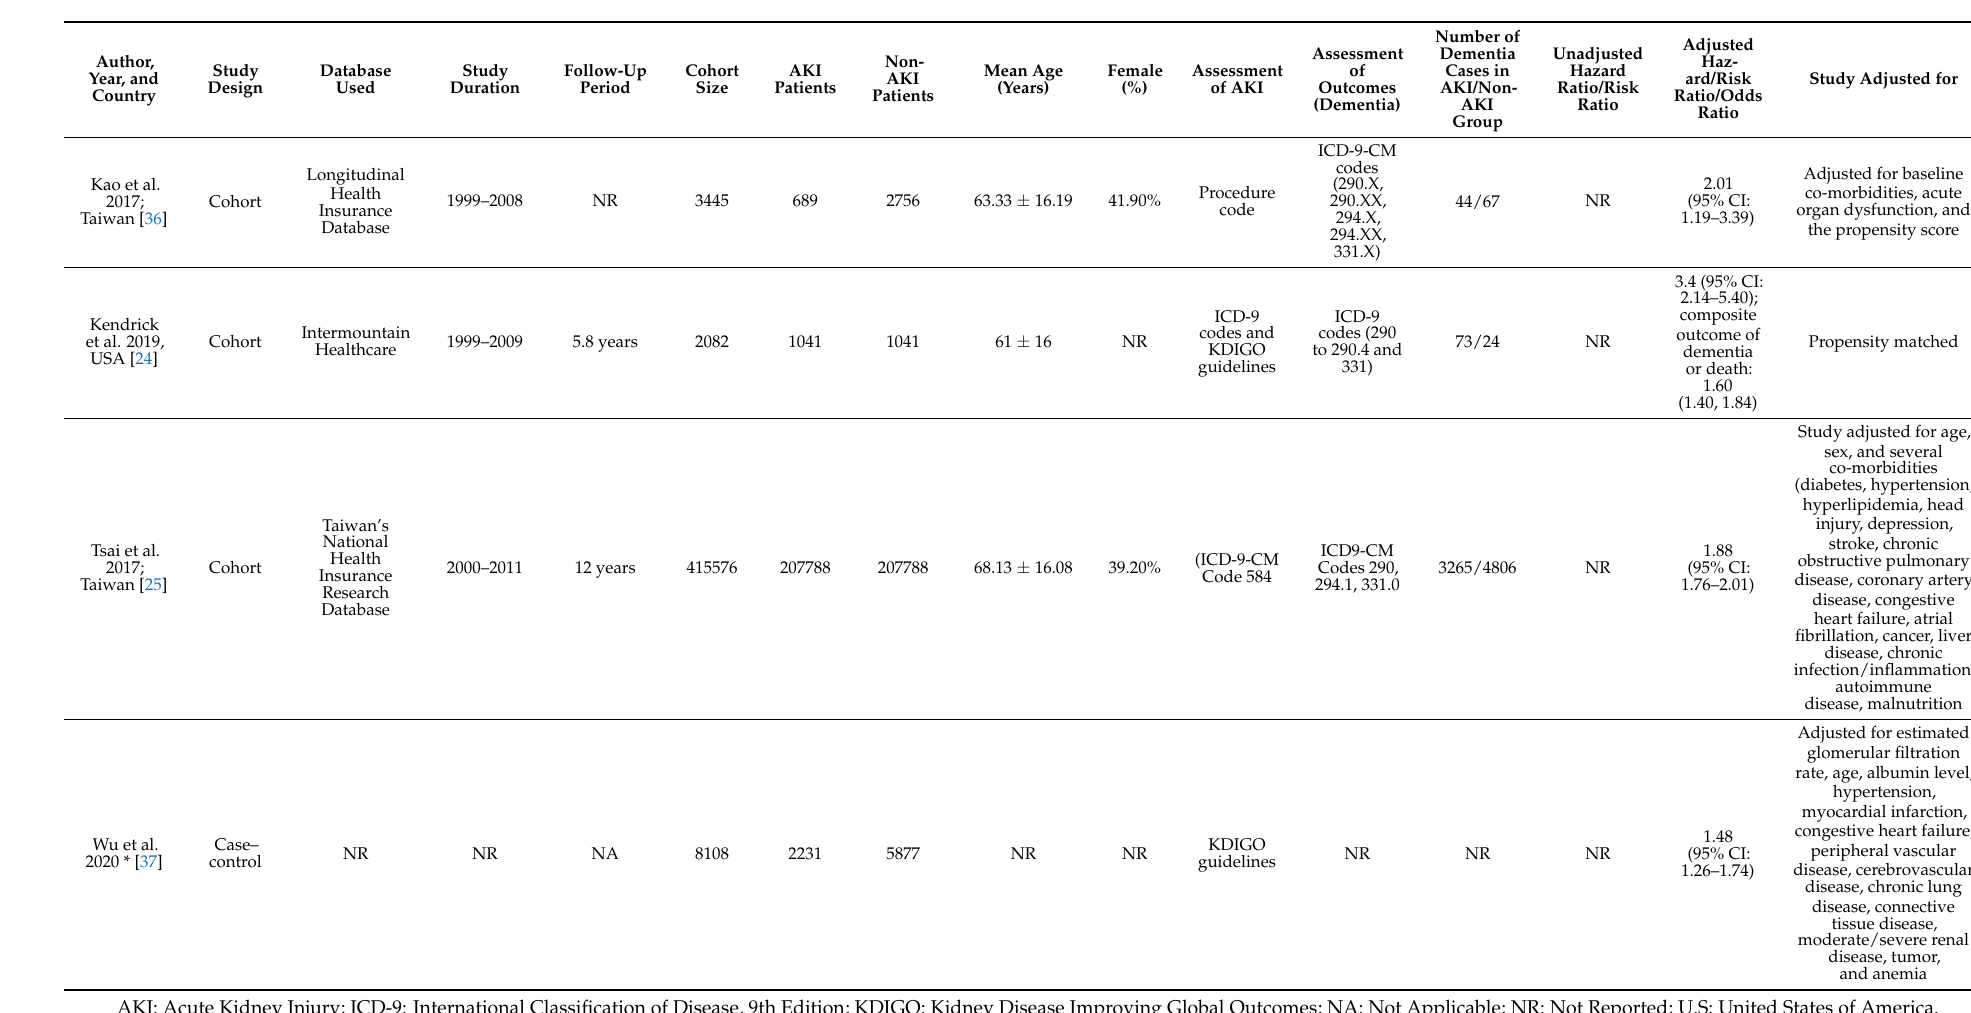
Table 1. Characteristics of included